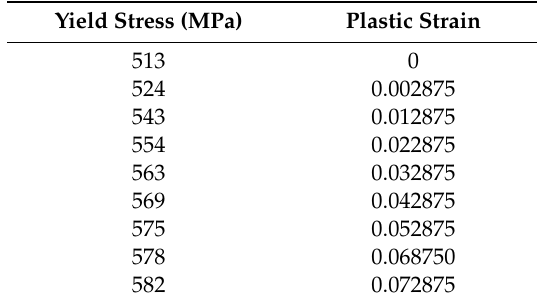
Table 6. Typical plastic properties of the aluminum 7075-T6 [18].